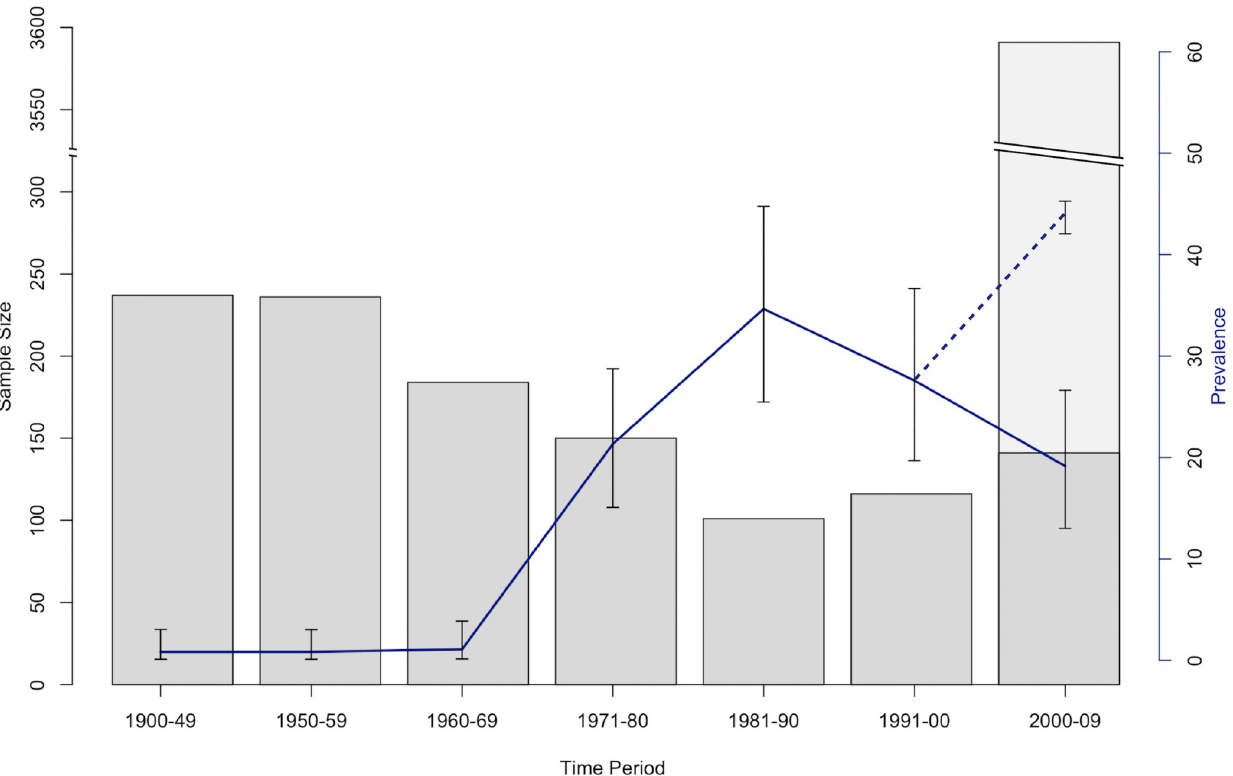
Fig 2. Bd infection prevalence in anurans of the Sierra Nevada from 1900–2009. Bar graphs denote sample size from each time period. Dark gray bars denote samples from museum specimens, and light gray bars denote samples collected from live animals in the field (live animal data from [7]). Blue line denotes Bd infection prevalence calculated from museum specimens only, and dotted blue line denotes Bd infection prevalence including both museum specimens and live animals in the field (i.e. museum specimens and data from [7]).